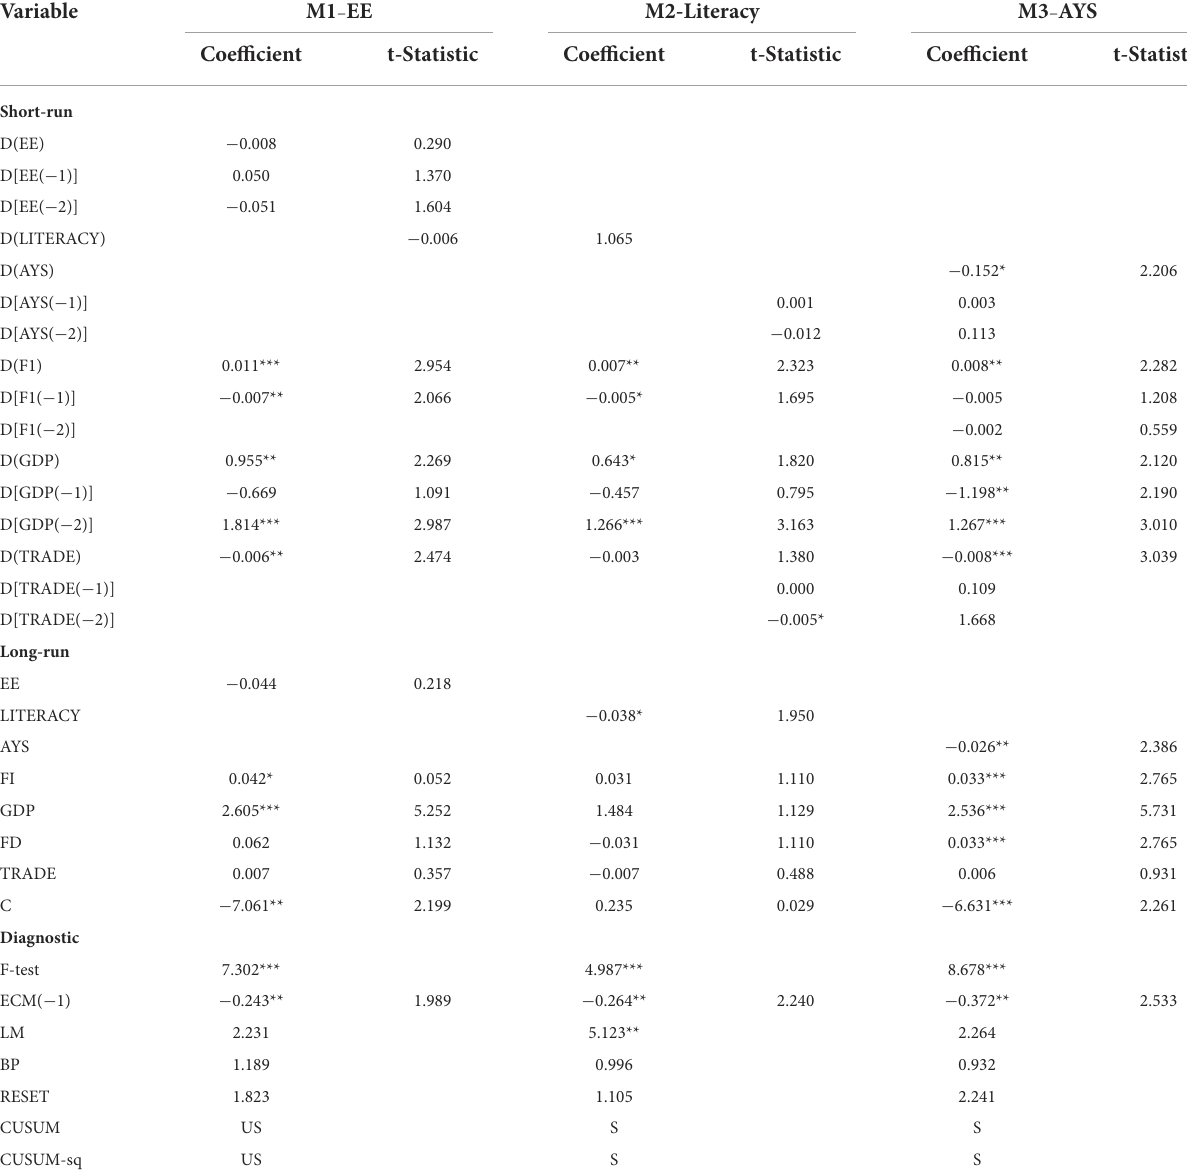
TABLE 3 ARDL estimates of human capital and CO 2